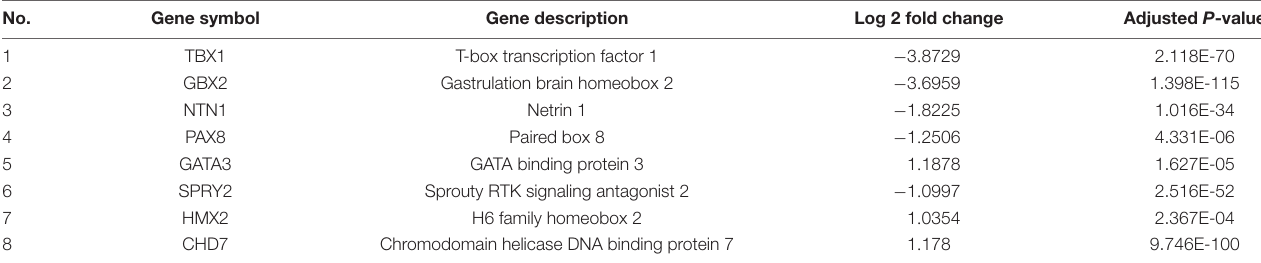
TABLE 1 | Differentially expressed genes in patient iPSC enriched in inner ear morphogenesis.